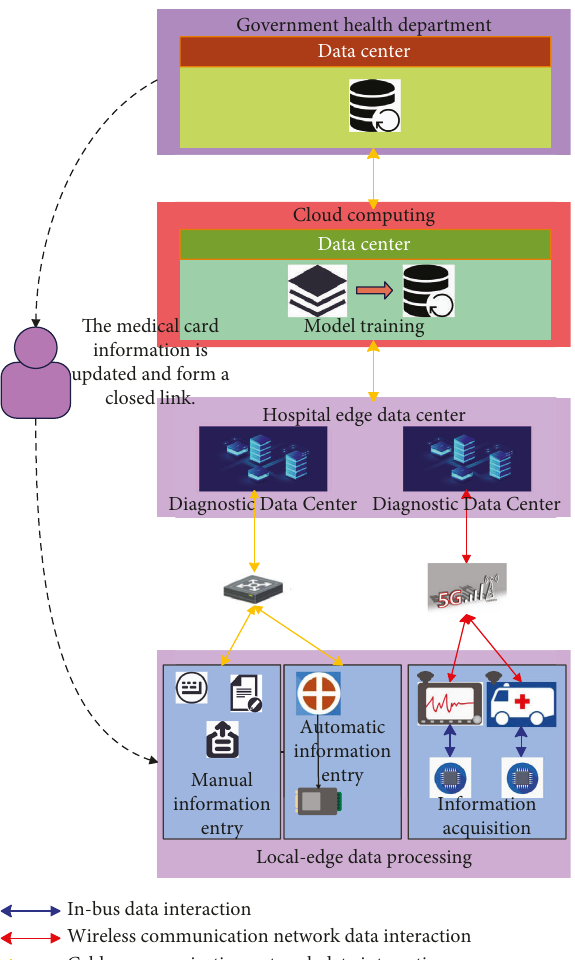
Figure 6: Schematic diagram of the process of edge computing in the field of smart medical